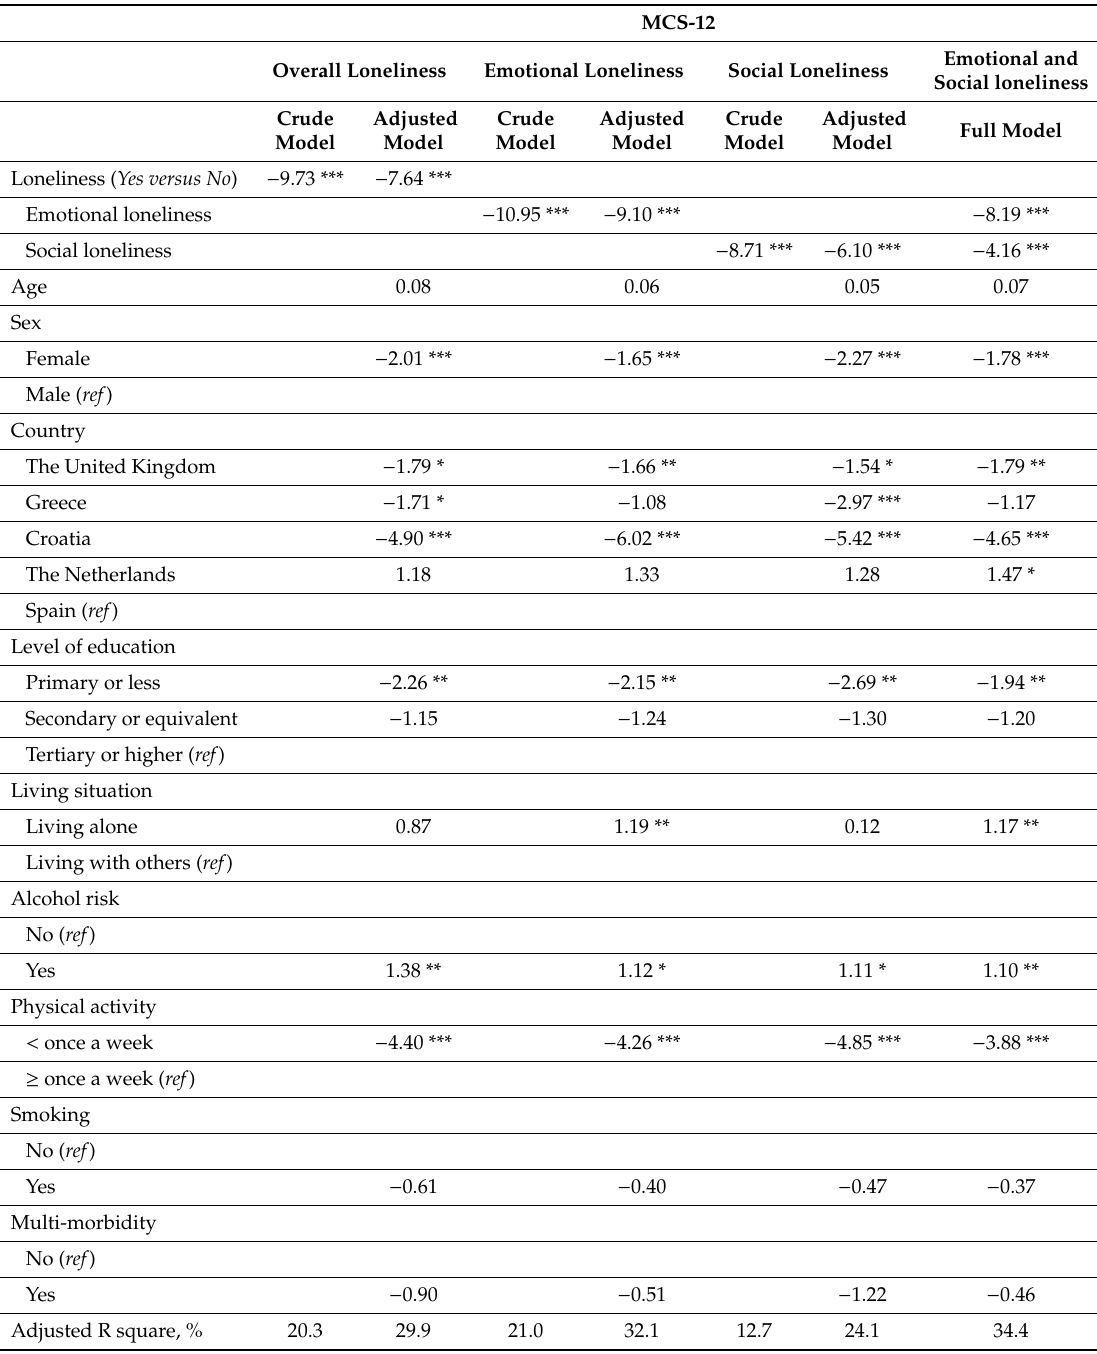
Table 5. Association between loneliness and mental Health-Related Quality of